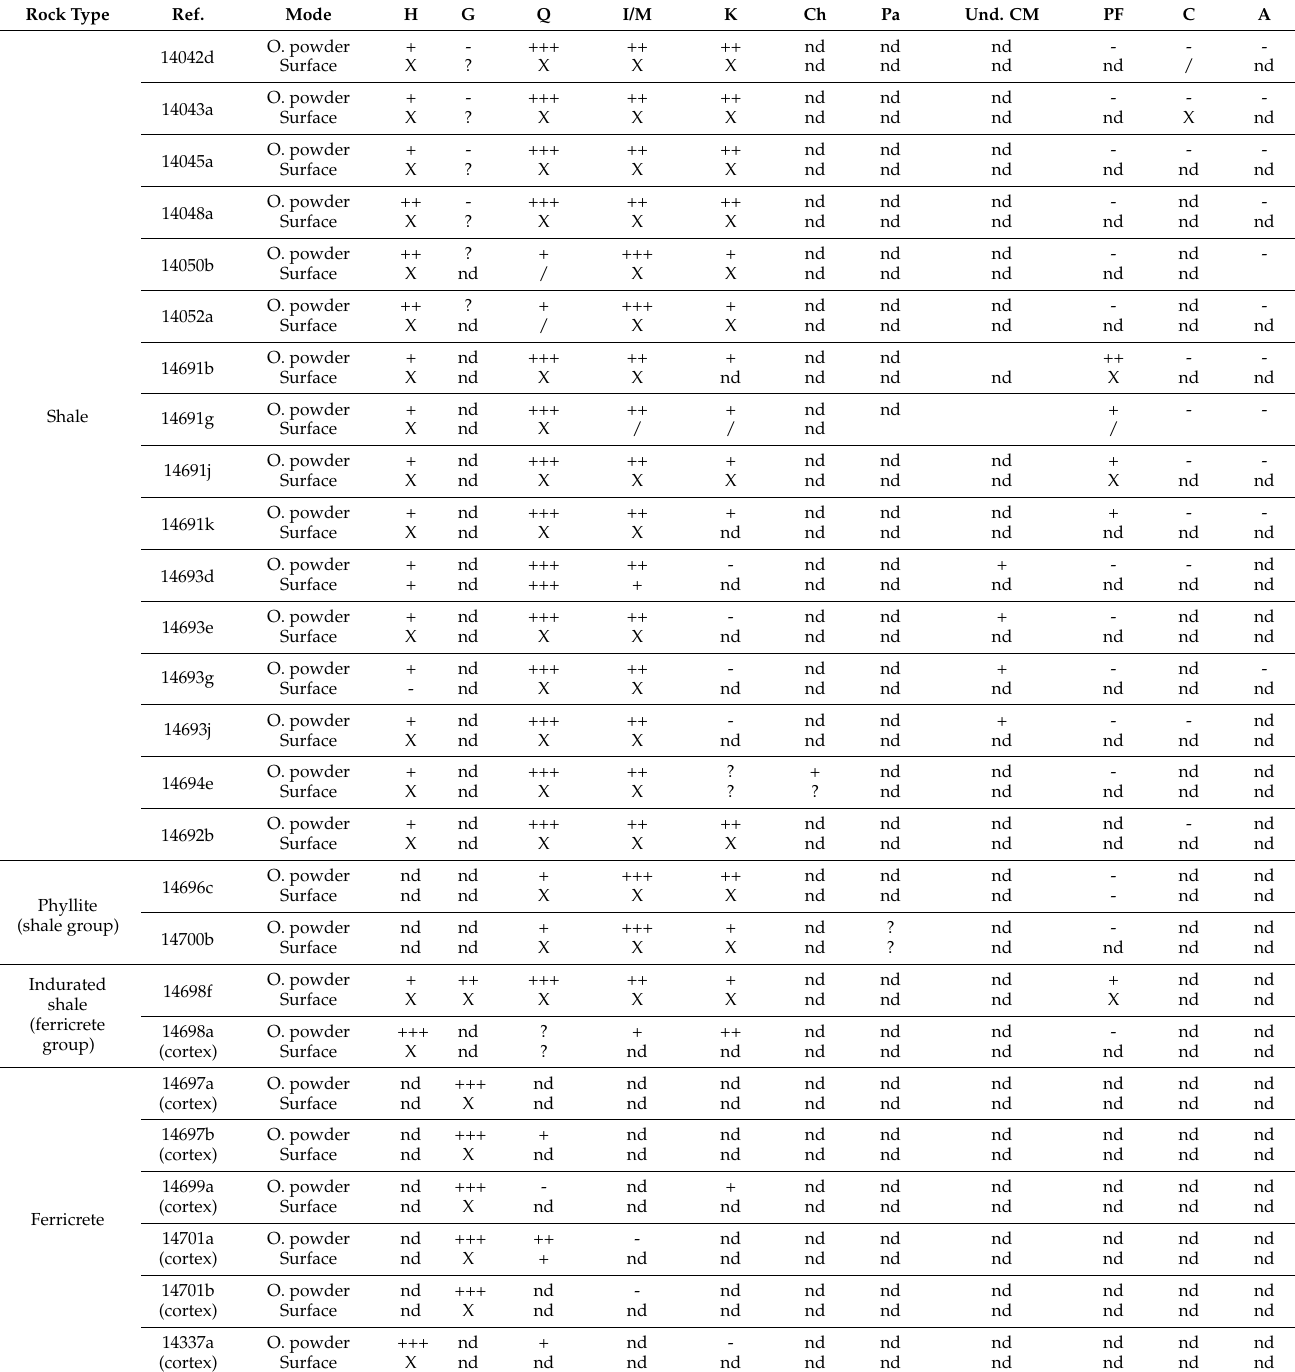
Table 5. Comparison by XRD between non-invasive analyses on cohesive pieces (surface) and invasive analyses on oriented powders (O. powder) for geological samples. Legend—H: hematite; G: goehite; Q: quartz; I/M: illite/mica; K: kaolinite; Ch: chlorite; P: paragonite; Und. CM: undetermined clay mineral (mixed-layer); PF: potassic feldspar; C: calcite; A: anatase. Rock Type